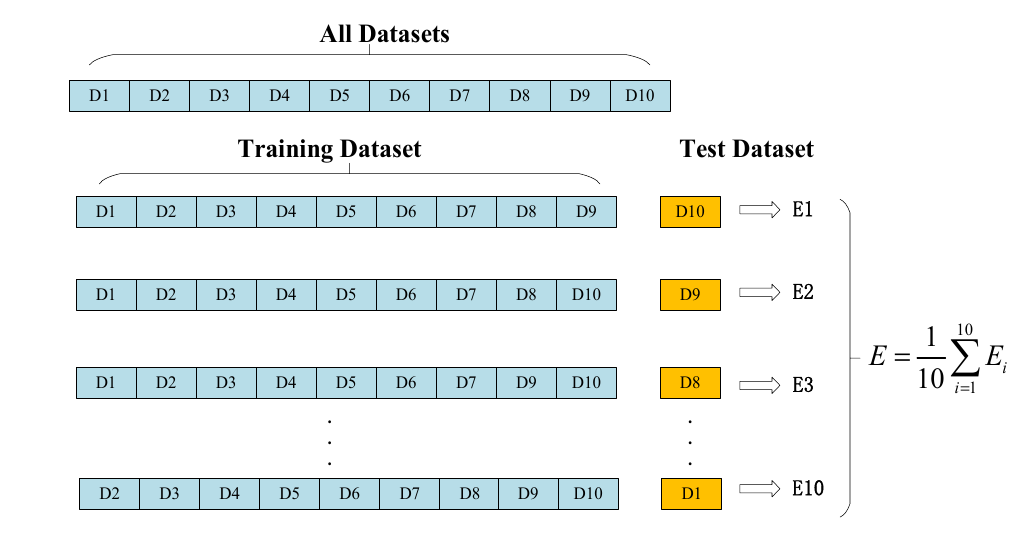
Figure 4. Schematic diagram of grid search and K − fold cross − validation.